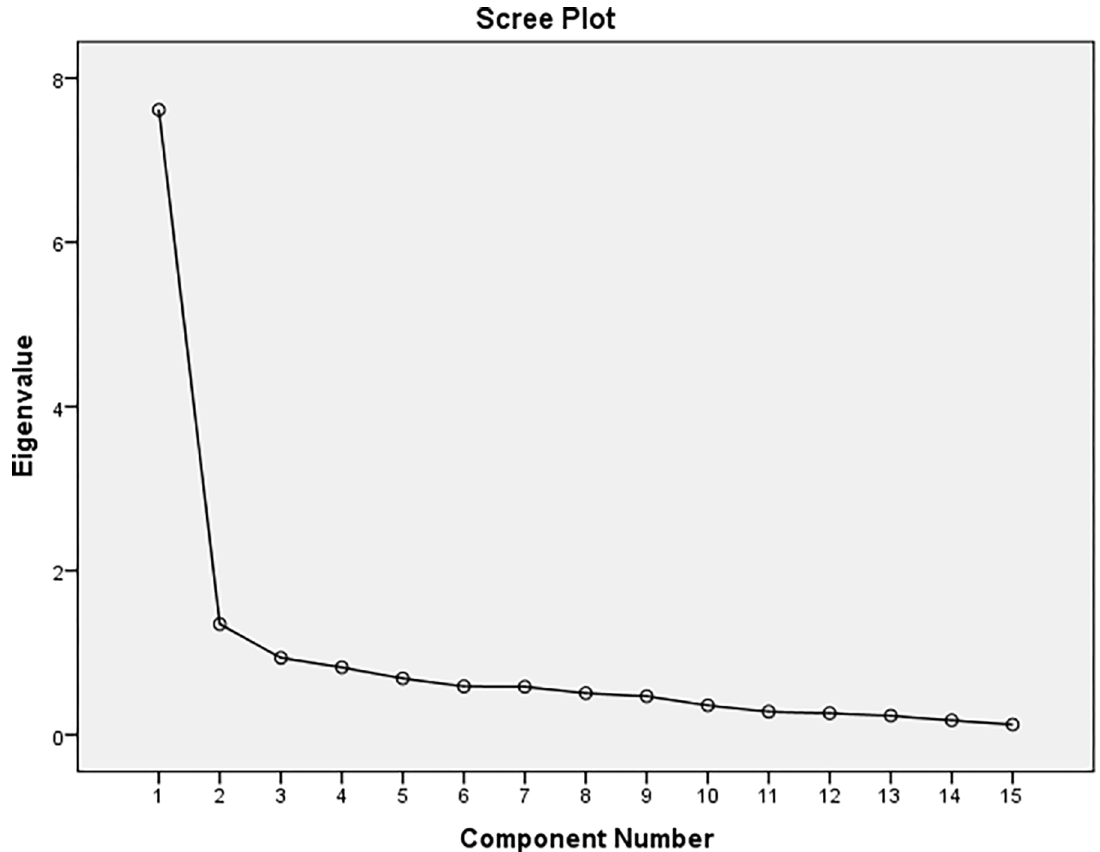
Figure 1. The scree plot of loading of the awareness in the construction industry